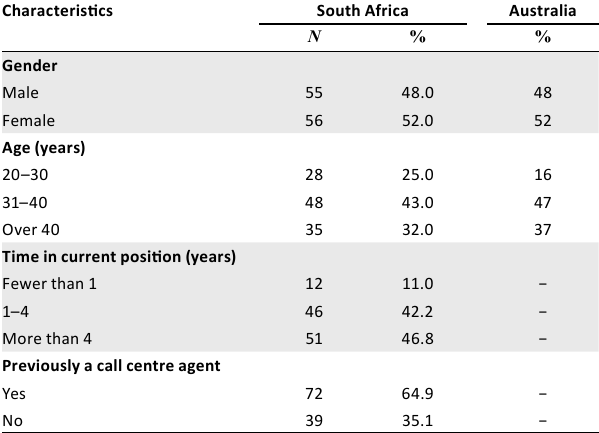
TABLE 2: Characteristics of call centre managers in South Africa and